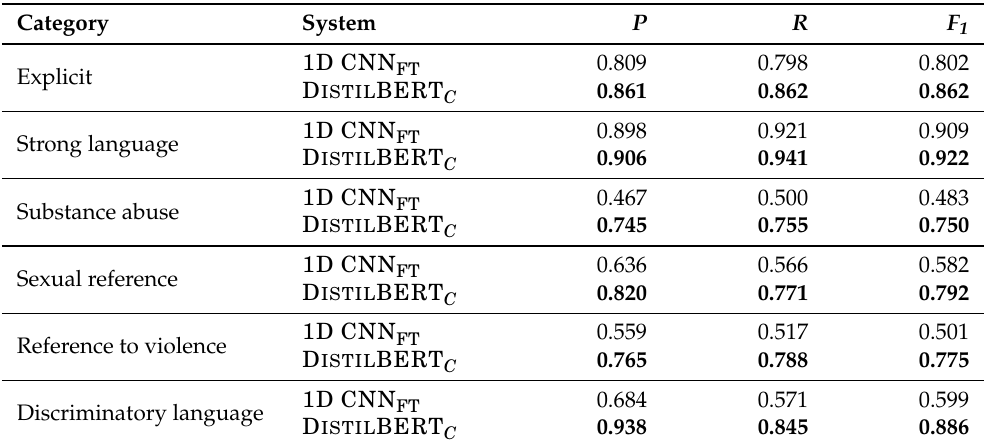
Table 2. Precision ( P ), recall ( R ), and F 1 scores of two multi-label text classification systems ( 1D CNN FT , D ISTIL BERT C ) for predicting the explicitness of song lyrics and the reasons for the explic- itness. The highest scores are highlighted in